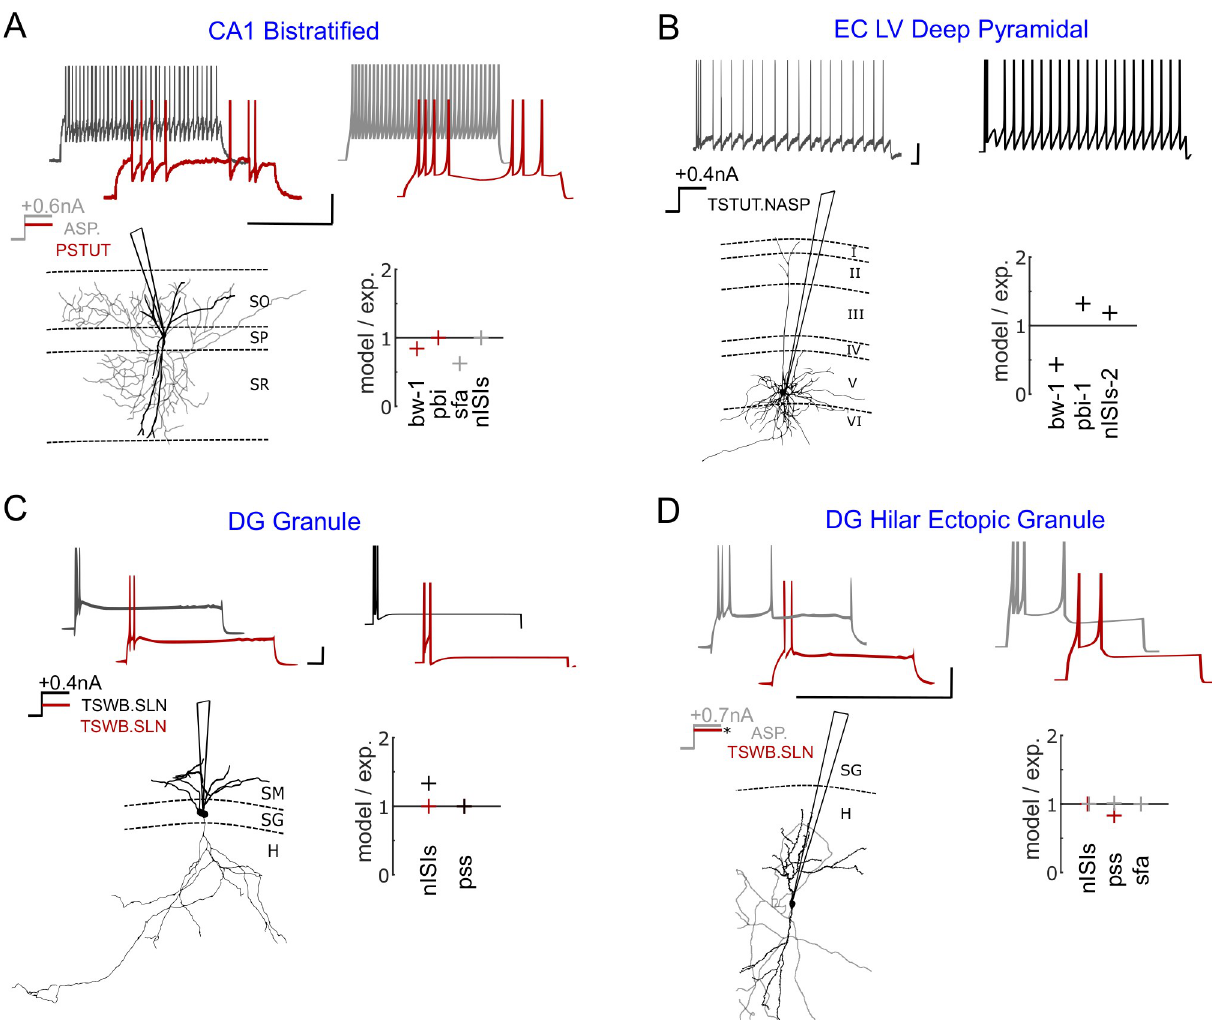
Fig 2. Exemplar models of stuttering/bursting phenotypes. ( A ) Complex phenotype of a Bistratified neuron in CA1. This neuron elicits a stuttering pattern for +0.4 nA (red) and a spiking pattern for +0.6 nA (grey) [29]. The digitally reconstructed morphology [30] was reproduced from NeuroMorpho. Org [26]. ( B ) The voltage trace recorded from an entorhinal layer-5 neuron shows both (transient) bursting and (steady state) spiking features for +0.4 nA [31]. ( C ) A DG granule neuron transiently bursts for both +0.2 nA and +0.4 nA with quantitative difference [32]. The digitally reconstructed morphology was reproduced from NeuroMorpho.Org [26,33].( D ) A dentate gyrus neuron that transiently bursts just above its rheobase (red) elicits a spiking pattern with a strong sfa (grey) for a higher input current [34]. ‘ � ’ indicates the unknown magnitude of the input current near rheobase. All voltage traces were digitized by Hippocampome.org . Experimental spike amplitudes are truncated. Calibration bars denote 200 ms and 20 mV in all panels. Goodness-of-fit is given only for key features (see S3 Table for all features). The experimental traces in panels A, B and D are intracellular recordings and the trace in panel C is a whole-cell patch clamp recording. currents from a DG Total Molecular Layer neuron were identified as ASP. (Fig 1A), and the two patterns recorded from a CA1 Basket neuron were identified as NASP. (Fig 1B). Such sim- ple-behavior neurons typically show different quantitative features among different patterns of the same class. In the former example, the three ASP. traces were experimentally recorded under +0.075 nA (red), +0.100 nA (black), and +0.200 nA (grey) [25]. The ISI counts ( nISIs ) are 5, 9, and 19, and sfa magnitudes are 0.142, 0.114, and 0.056 respectively for the red, black and grey traces. The model of this neuron type was constrained to quantitatively reproduce the spike pattern features for similar input currents: nISIs of 5, 9 and 19, and sfa magnitudes of